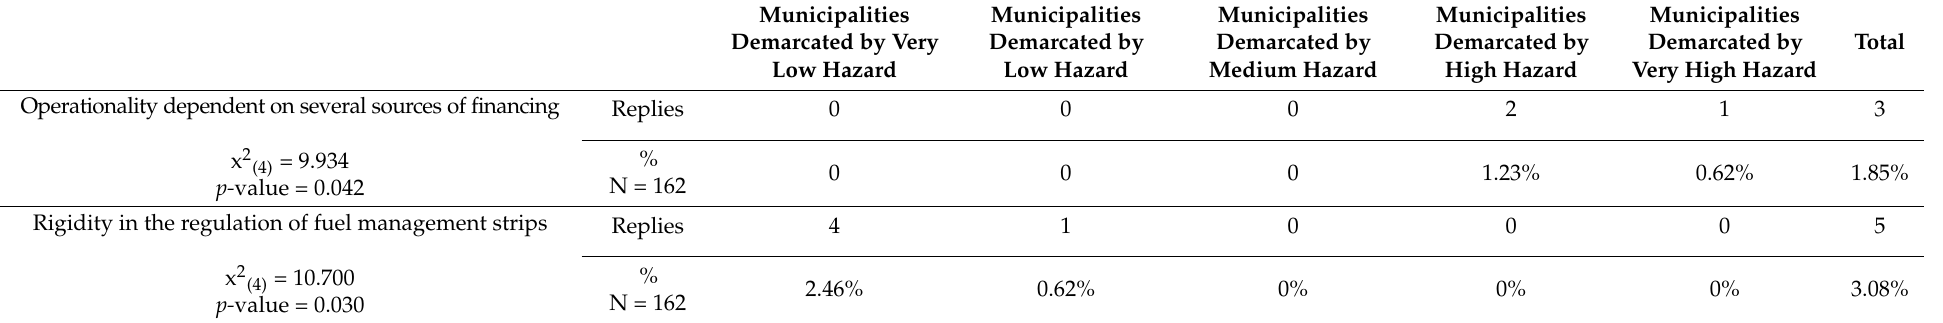
Table 1. Relationships with statistical significance that were established between the difficulty of operationality dependent on several sources of financing , the difficulty of rigidity in the regulation of fuel management and the influence of hazard categories in the municipalities.